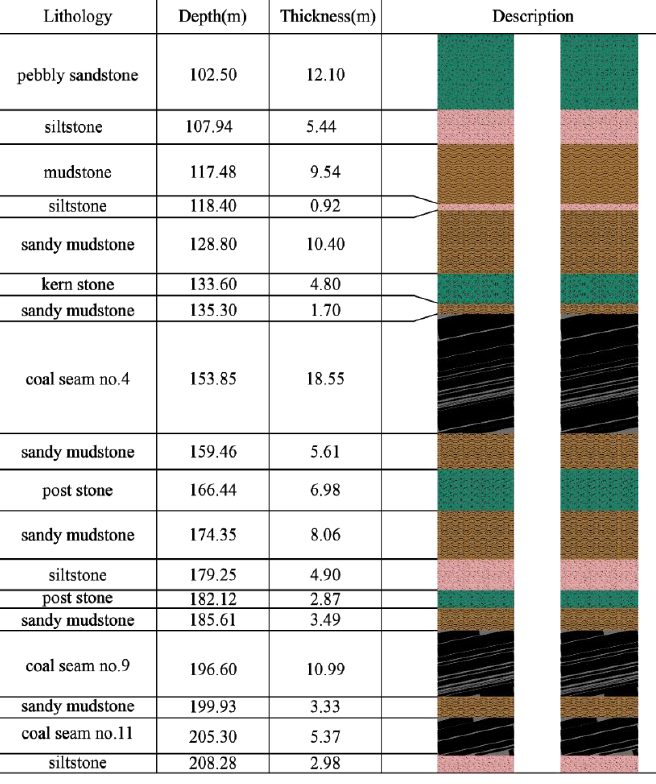
Figure 2. Lithology of the typical borehole.